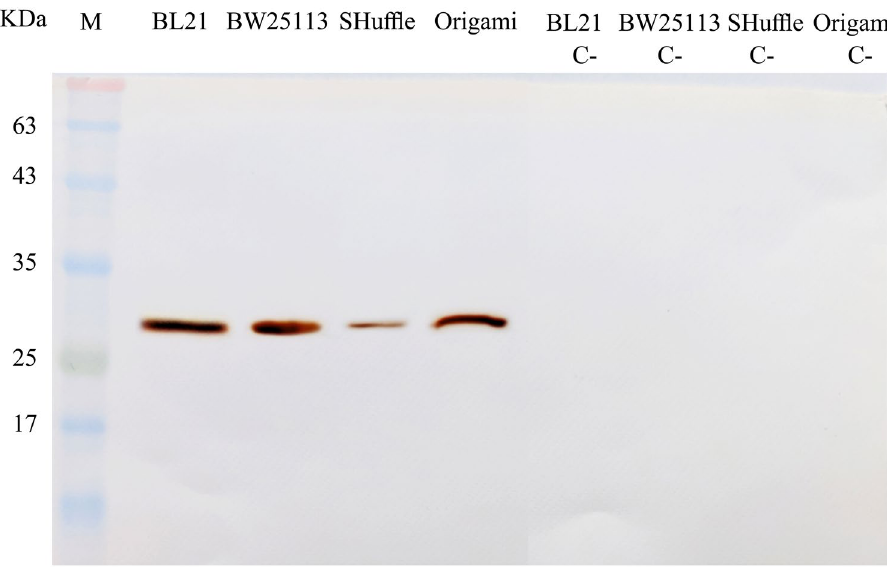
Figure 2. Western blotting analysis of the antiEpEX-scFv recombinant protein. Bacterial lysates of BL21(DE3), BW25113(DE3), SHuffle T7 and Origami(DE3) before (C-) and after induction were electrophoresed. After separation, protein bands were transferred onto the PVDF membrane and treated with anti-6 × His tag